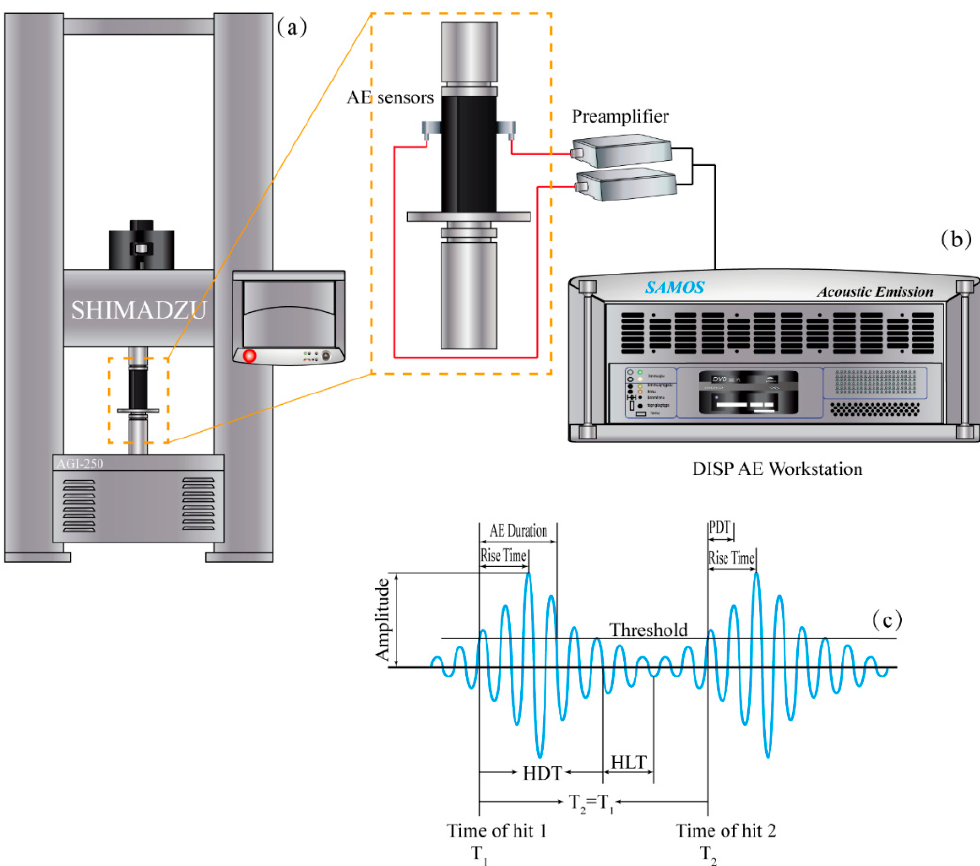
Figure 2. The sketch map of experimental system. ( a ) loading equipment, (SHIMADZU AGI-250 high-precision electric-servo digital experiment machine, Japan), and insert shows the coal sample and acoustic emission (AE) sensor arrangements, ( b ) real-time AE detection device. ( c ) the original AE signal feature extraction diagram, A proper setting of the peak definition time (PDT) ensures correct identification of the signal peak for rise time and peak amplitude measurements. Proper setting of the hit definition time (HDT) ensures that each AE signal from the structure is reported as one and only one hit. The AE system needs hit lockout time (HLT) to get ready for the next signal detection.